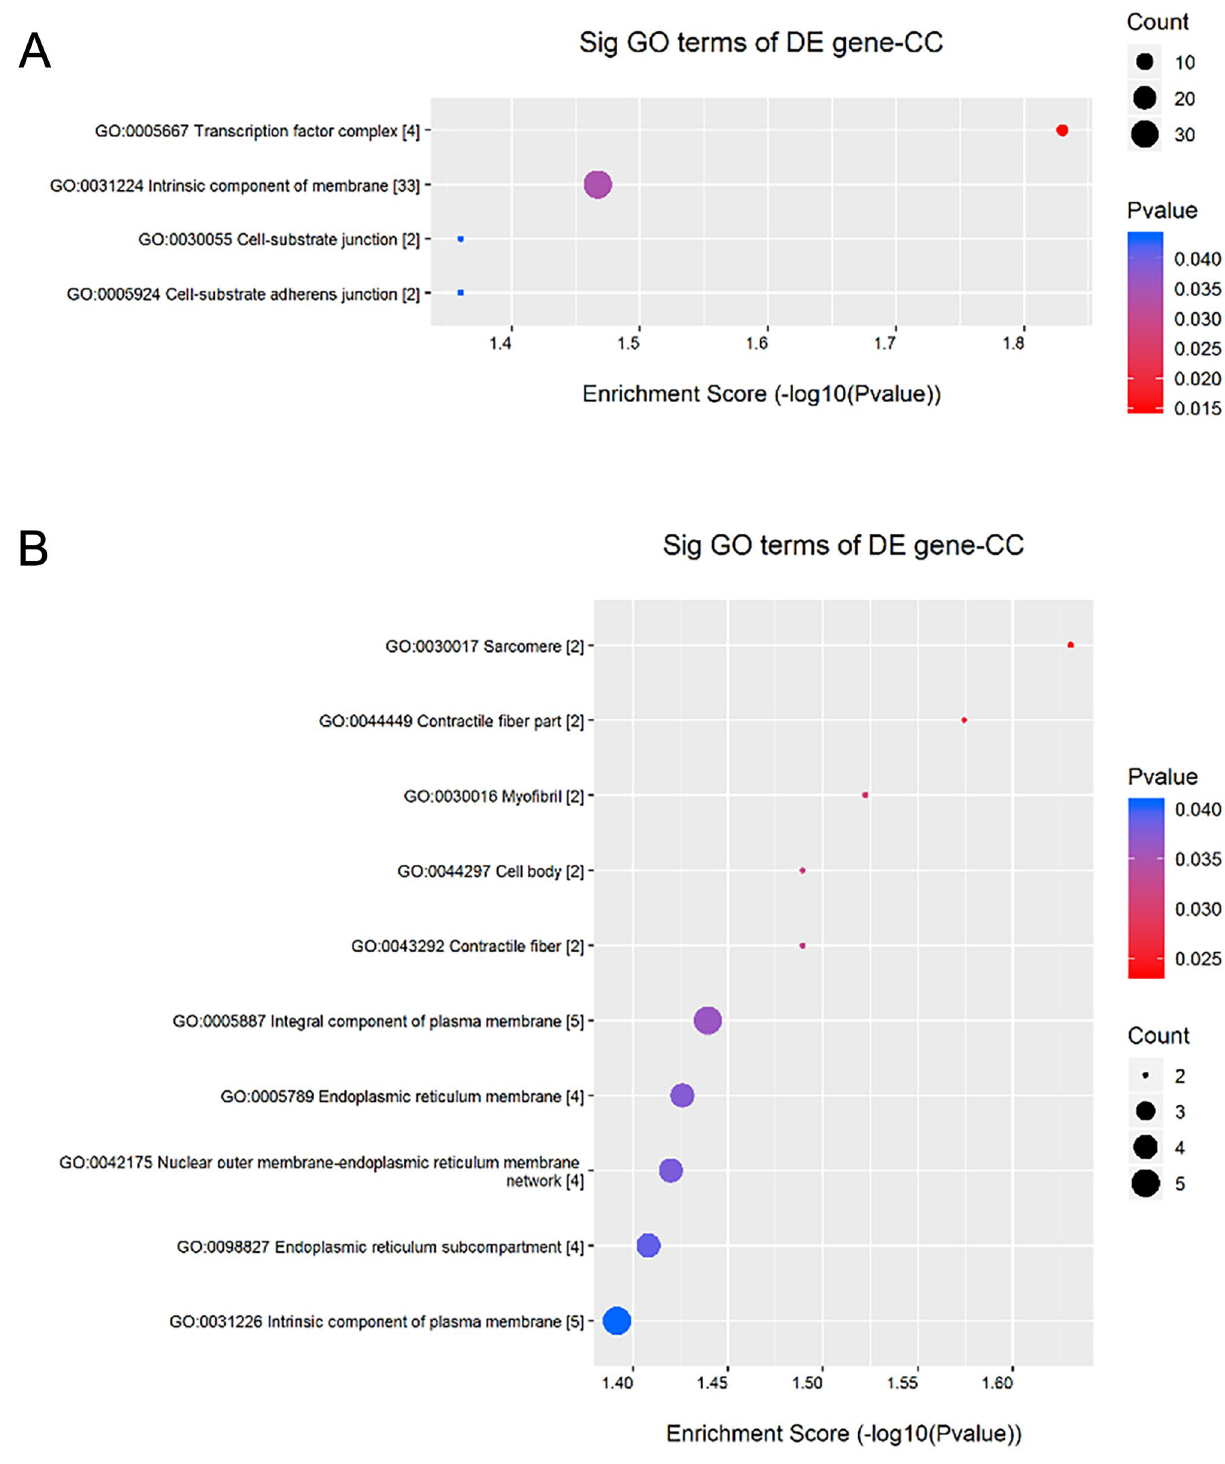
Figure 4. The cellular components enrichment analyses for the differentially expressed genes (DEGs) analysed by Gene Ontology (GO). ( A ) The Cellular components with upregulated Enrichment Score Dot Plot. ( B ) The Cellular components with down-regulated Enrichment Score Dot